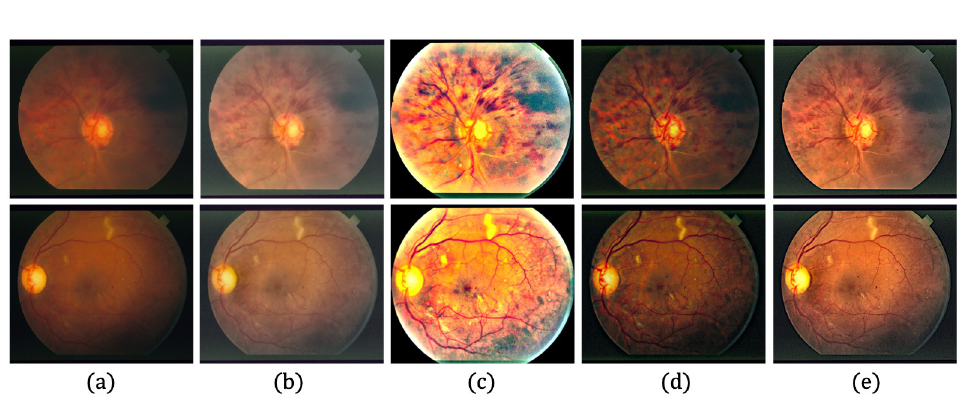
Fig 9. Qualitative comparison of two LQ image samples from the STARE database. (a) Input LQ images, and results using the methods of (b) Zhou et al. [42], (c) Gaudio et al. [88], (d) Dai et al. [89], and (e) the proposed method.